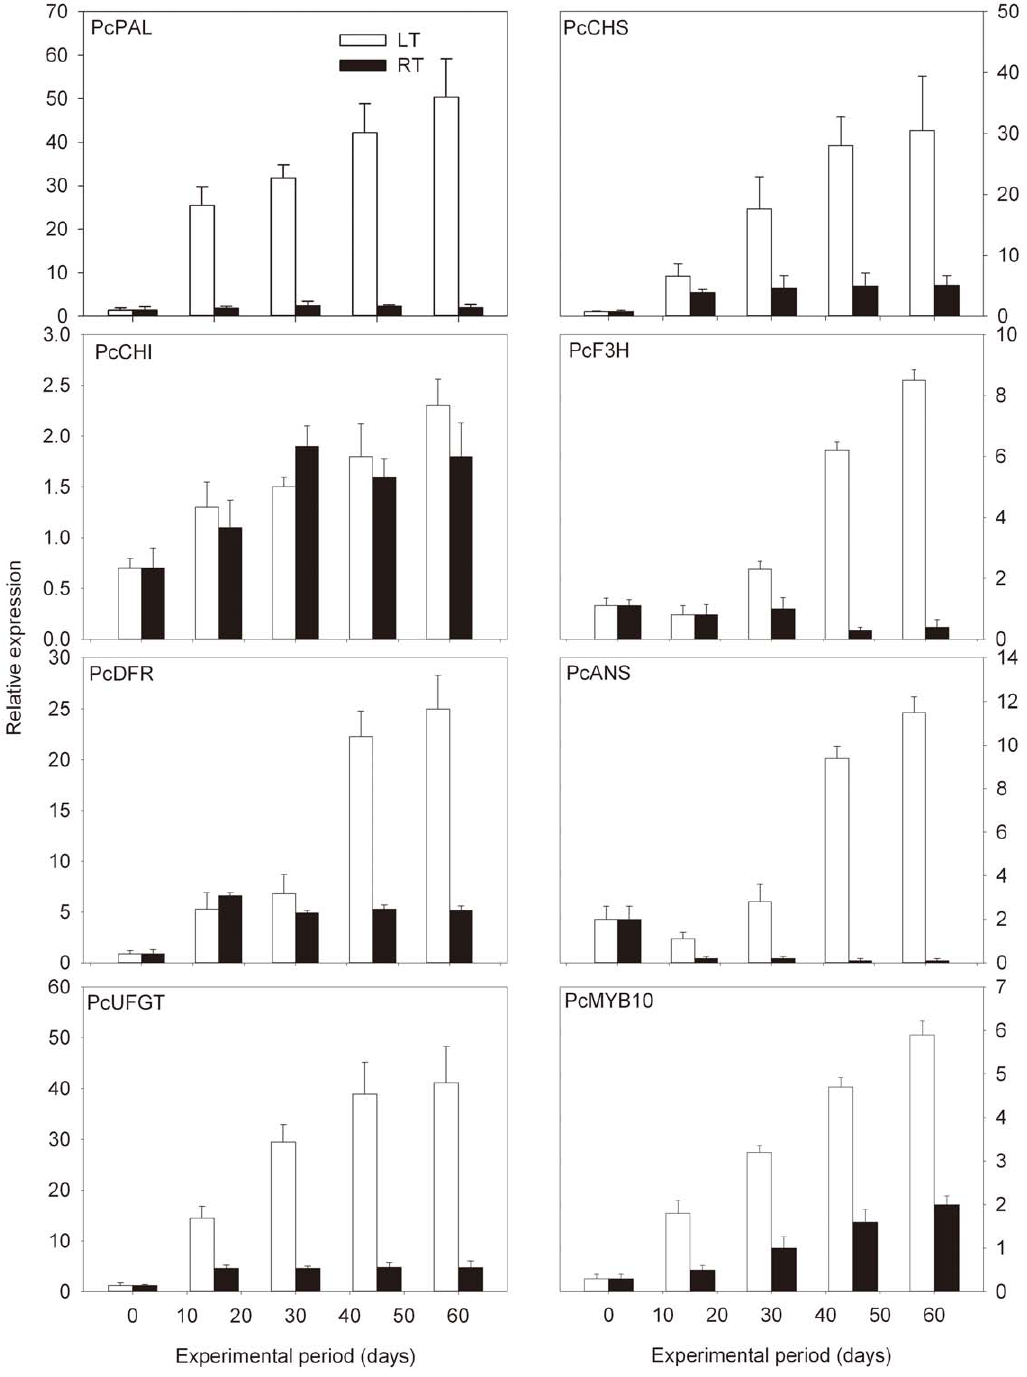
Figure 4. Expression profile of anthocyanin biosynthetic genes in ‘Wujiuxiang’ pears exposed to LT and RT. The sampling and quantitative RT-PCR details are described in Figure 2. doi:10.1371/journal.pone.0046070.g004 second (S2) and third stages (S3). For gene expression under both temperatures, the behavior significantly appeared different between LT and RT storage, and was well correlated with the experimental period between 15 and 60 d storage, which indicates evident changes in the expression of anthocyanin biosynthetic genes induced by LT (Figure 6B). As shown in Figure 6A, for row